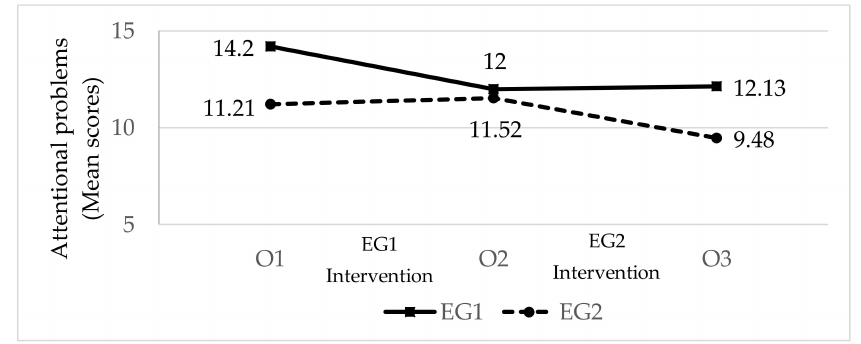
Figure 1. The e ff ect of the intervention on pupils’ attentional problems (n GE1 = 40; n GE2 = 33; EG = Experimental Group; O =